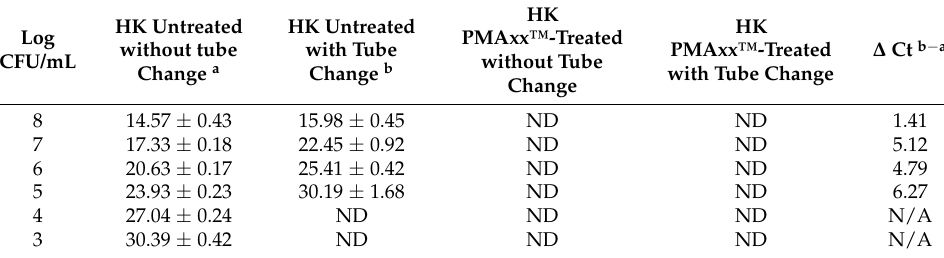
Log Table 4. Average Ct values for the effect of PMAxx™ treatment * and tube change on HK cells. HK Untreated HK Untreated Log without tube with Tube CFU/mL Change a